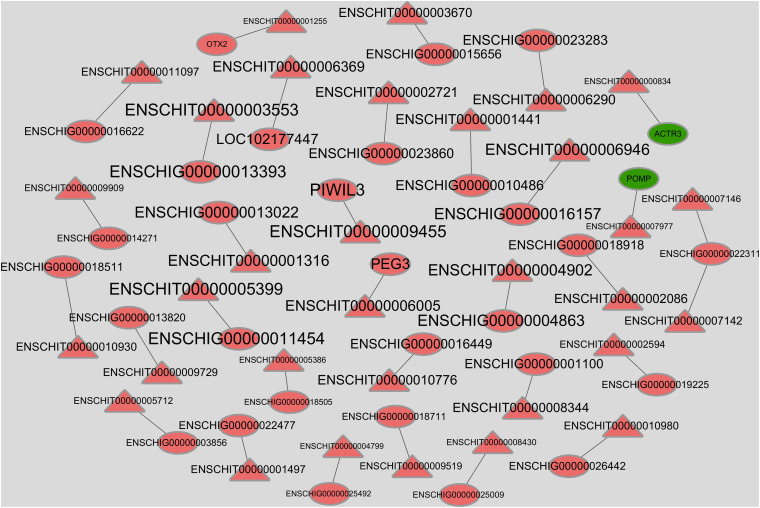
Co-expression network of DElncRNAs and DEmRNAs. The red label represents the up-regulation gene in small follicle, and the green label represents the down-regulation gene in small follicle. The circles represent mRNAs and the triangles represent lncRNAs. The sizes of the labels were arranged according to the absolute value of Pearson correlation coefficient; the larger the value, the larger is the size.